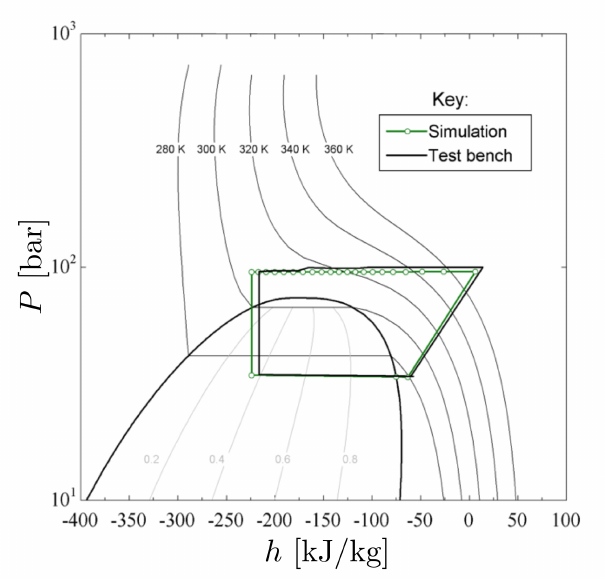
Figure 5. Log. P - h diagram with overlaid experimental and simulated refrigerant cycle (30% EV orifice